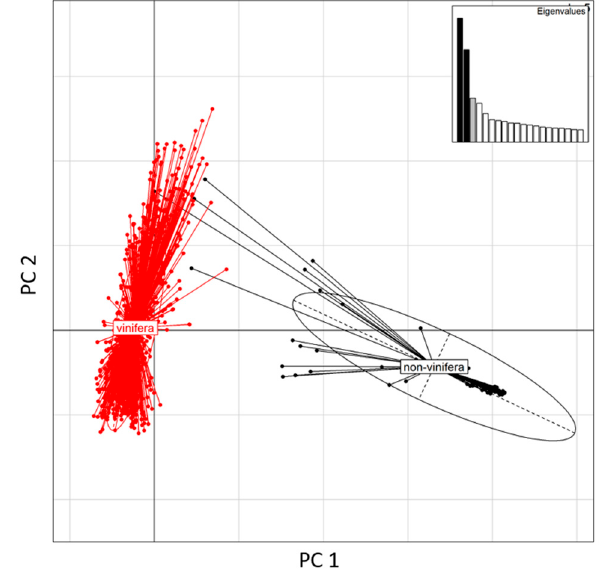
Figure 5. Principal component analysis (PCA) of non- vinifera (66 genotypes) and vinifera genotypes (978 genotypes [23,24,35]), defined using 6k SNP molecular markers.